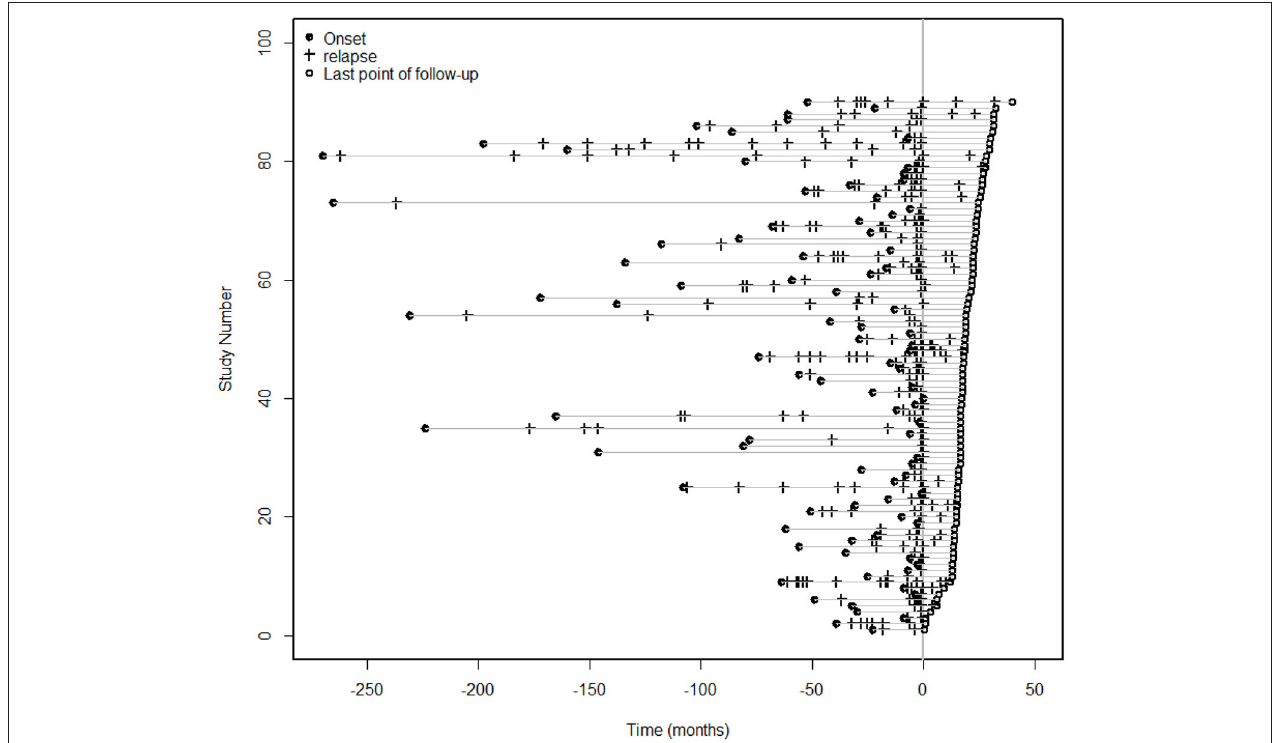
FIGURE 2 | Clinical episodes before and after MMF treatment. For the ARR analysis, we excluded patients with an MMF treatment duration of less than 6 months. The median duration of treatment for the 86 patients was 18 months (range 6–40 months), and the median ARR decreased from 1.02 before treatment to 0 after treatment ( P < 0.0001). A total of 90% of the patients had a reduction in the ARR, and 73% of the patients had no clinical recurrence.